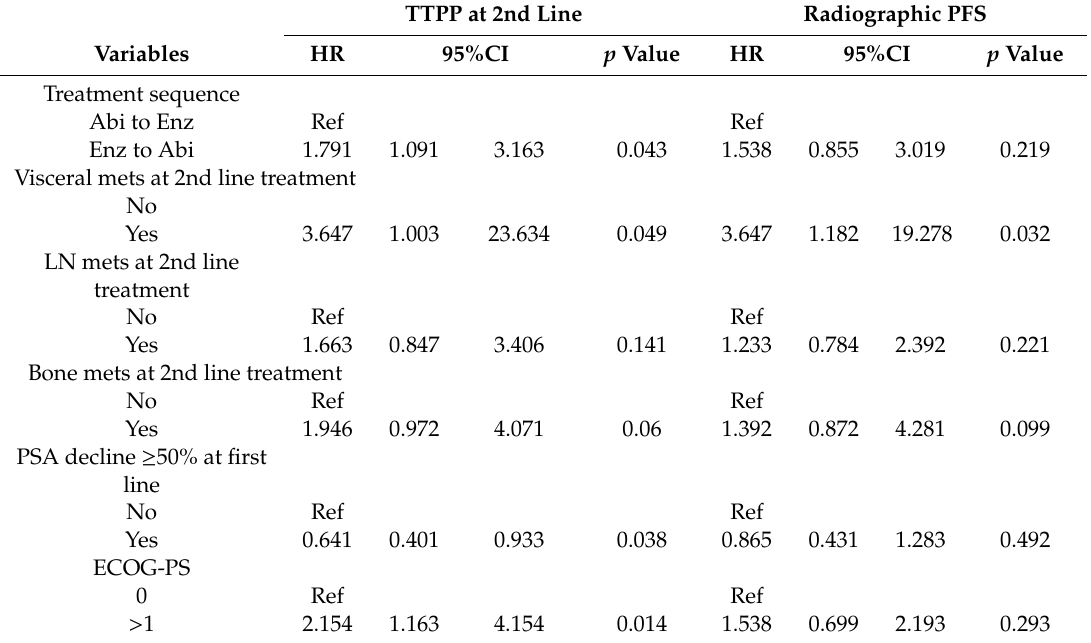
Table 3. Multivariate analysis adjusting with putative variables for the prediction of TTPP and rPFS from the initiation of second line treatment.